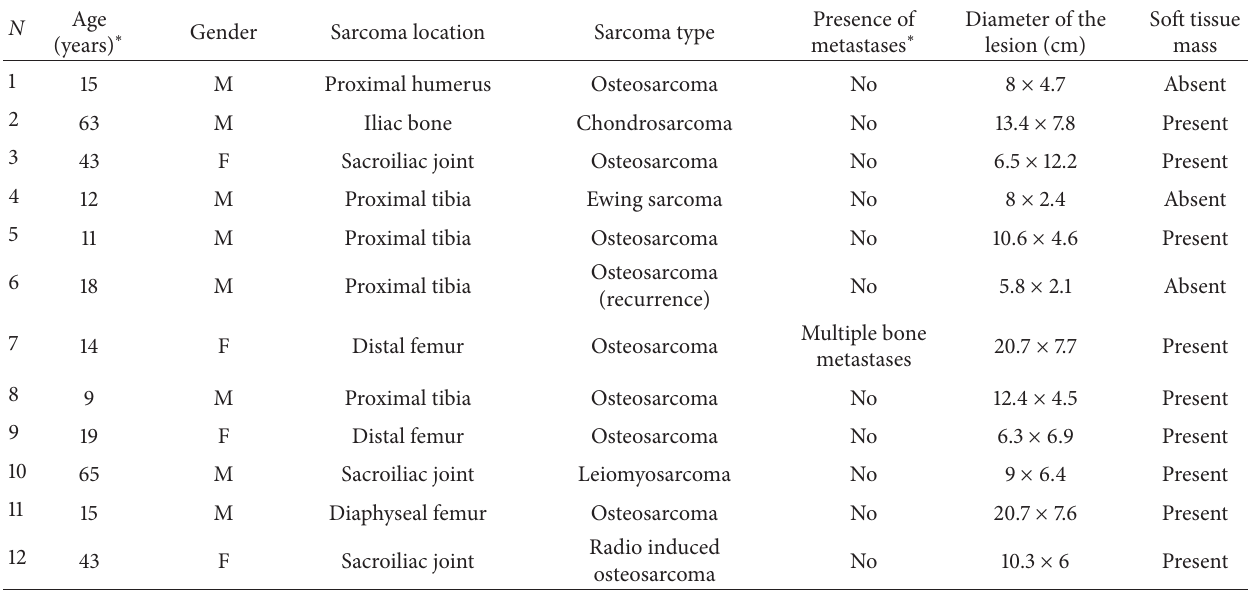
Table 1: Patient’s